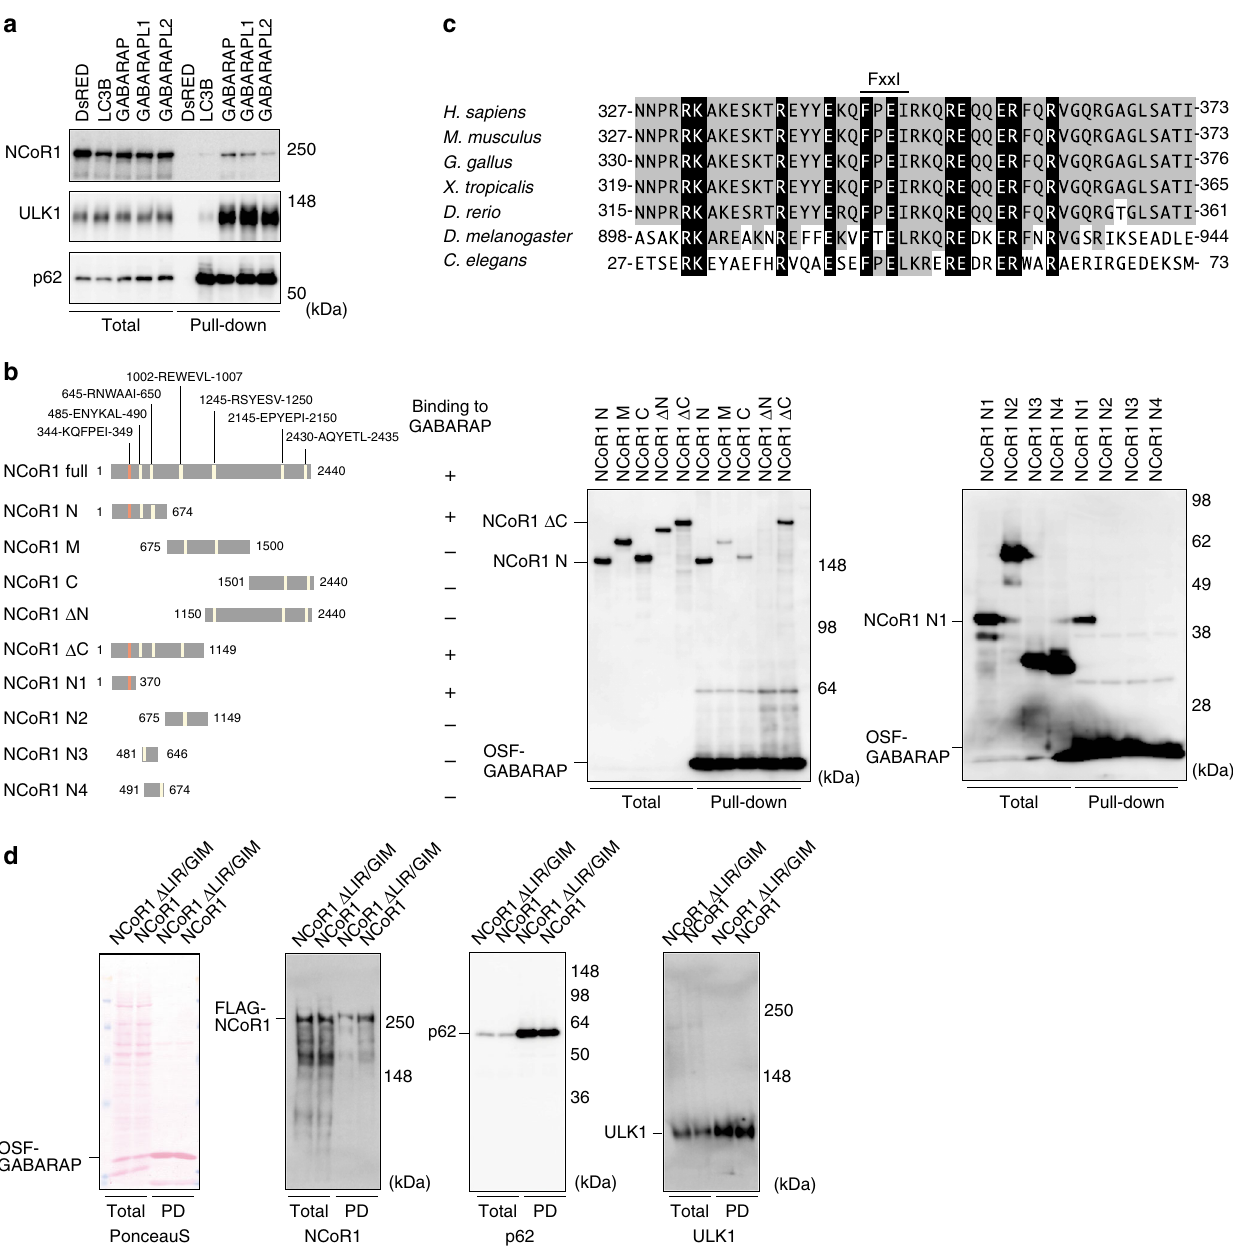
Institute (Osaka, Japan).